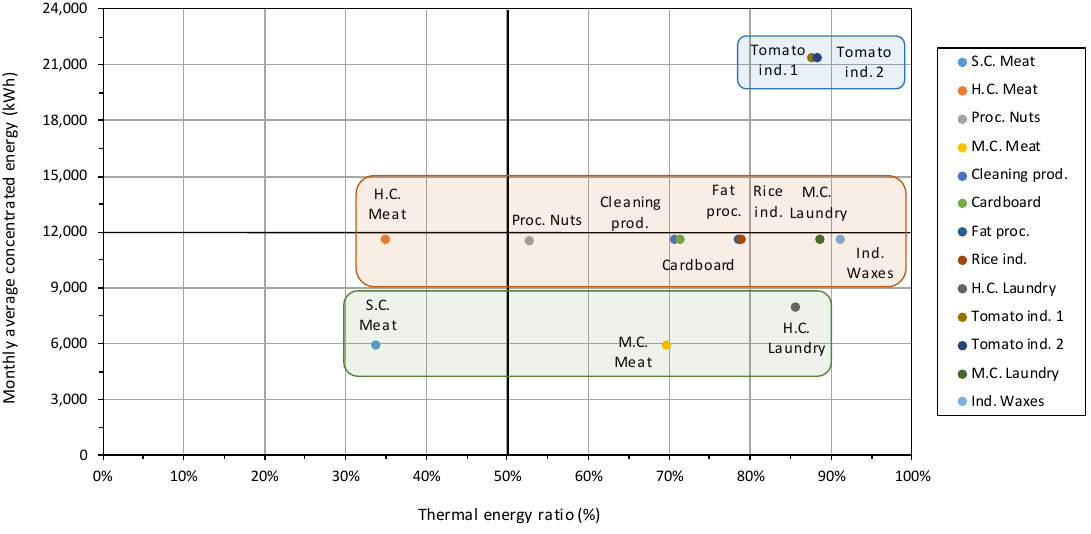
Figure 6. Thermal energy ratio vs monthly average concentrated energy.